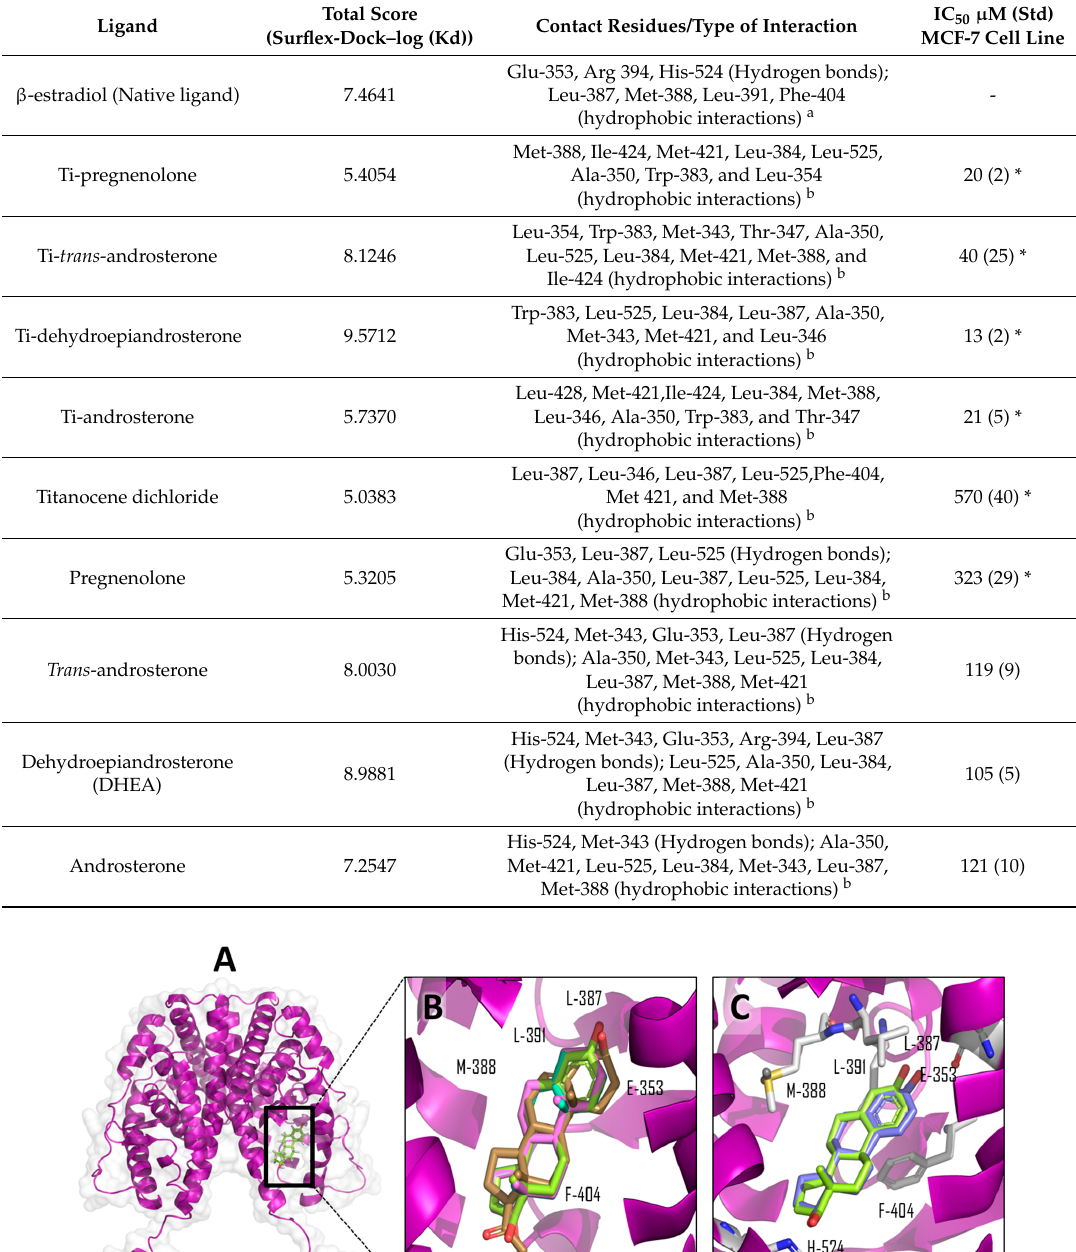
Table 2. Total score for Ti-derivatives, steroids, and β -estradiol on ligand-binding domains estrogen receptor (PDB: 1A52) and cytotoxic data of compounds on hormone-dependent breast cancer cell line MCF-7. “-“: no inhibitory activity under conditions tested. a Contact residues/type of interaction obtained from crystallographic structure, PDB: 1A52. b Contact residues/type of interaction predicted by LigandScout 3.1. std = standard deviation of four independent experiments; * = Values taken from [9]. Total Score Contact Residues/Type of Interaction Ligand (Surflex-Dock–log (Kd))